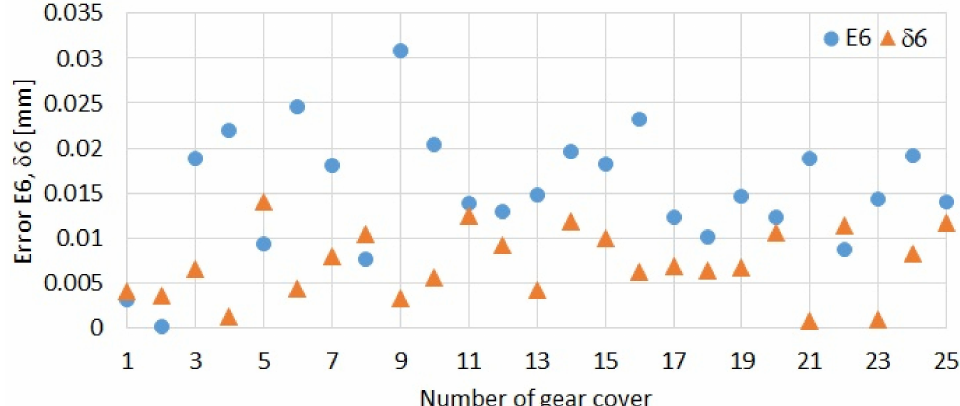
Figure 15. Summary of errors δ 6 and E 6 for the data from the test set for bearing seat